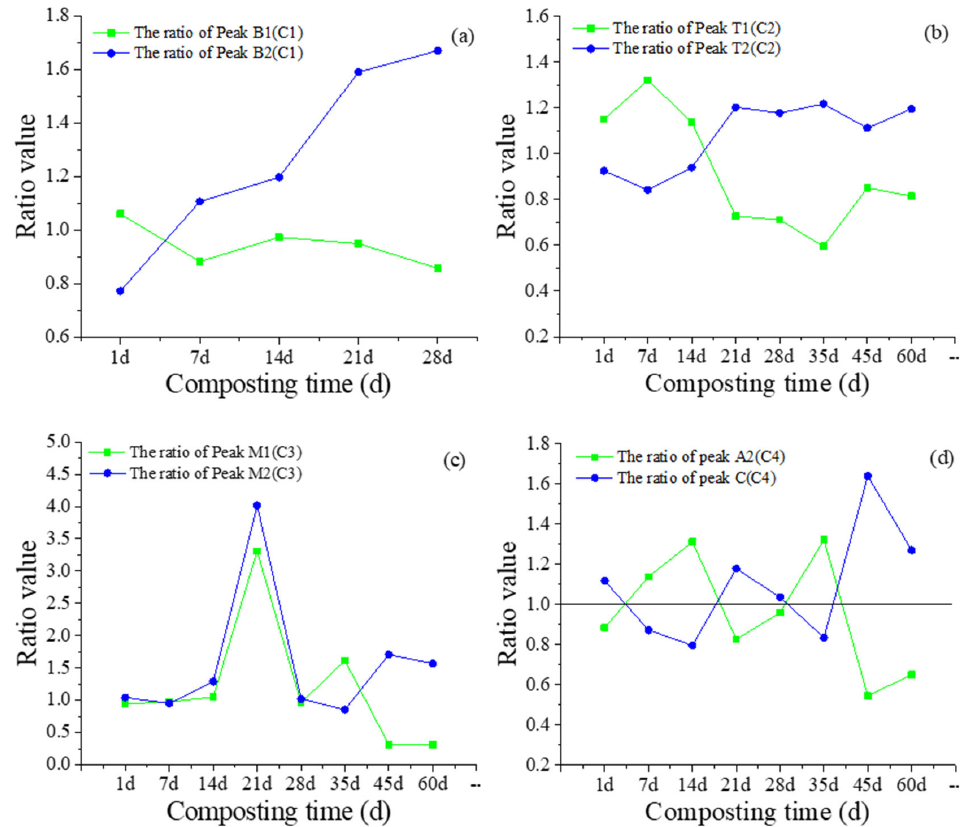
Figure 4. Changes in the ratio of DOM peaks (peak in first group/peak in second group) of PARAFAC molecules during composting. The changes of fluorescence peaks in DOM component C1 ( a ); The changes of fluorescence peaks in DOM component C2 ( b ); The changes of fluorescence peaks in DOM component C3 ( c ); The changes of fluorescence peaks in DOM component C4 ( d ).